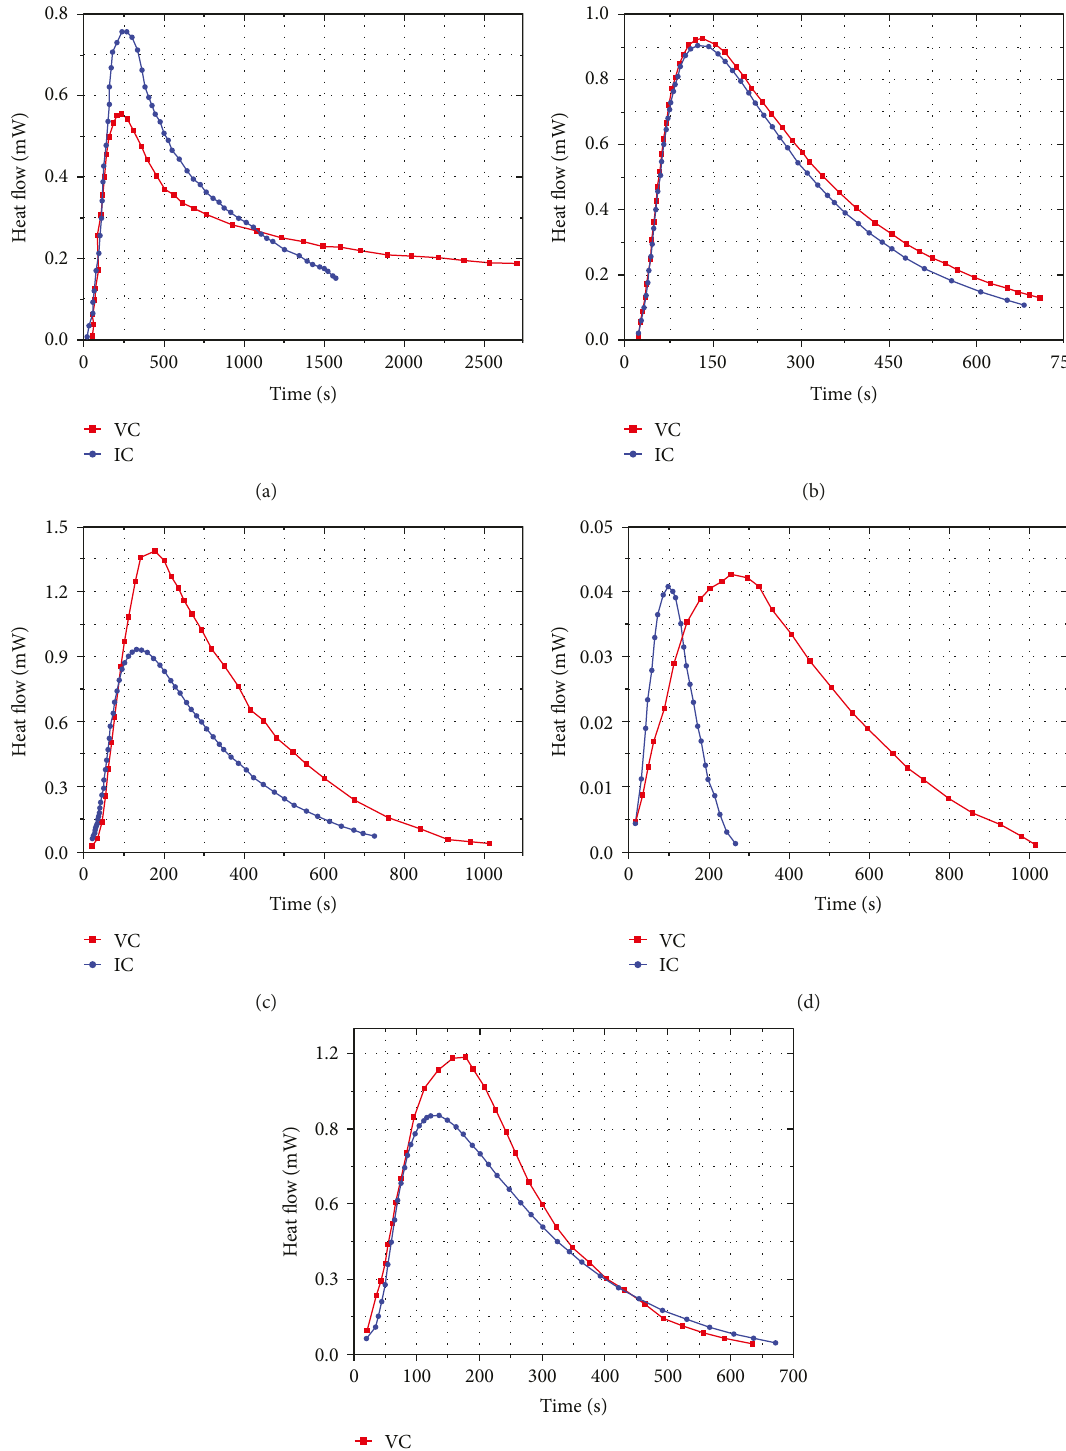
Figure 7: Curves of fl ux of methane adsorption heat released from maceral concentrates of coal sample numbers 1 (a), 2 (b), 3 (c), 4 (d), and 5